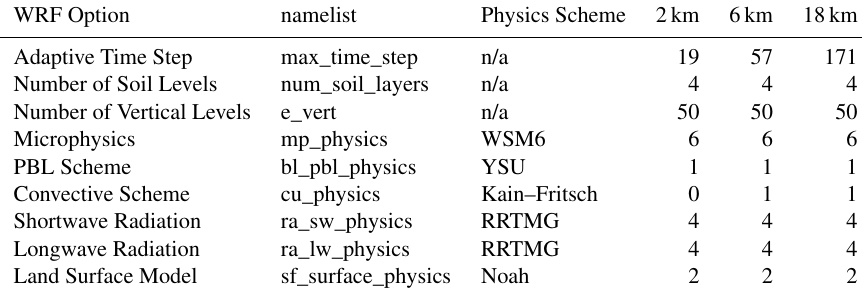
Table 2. Namelist options used for each of the three WRF